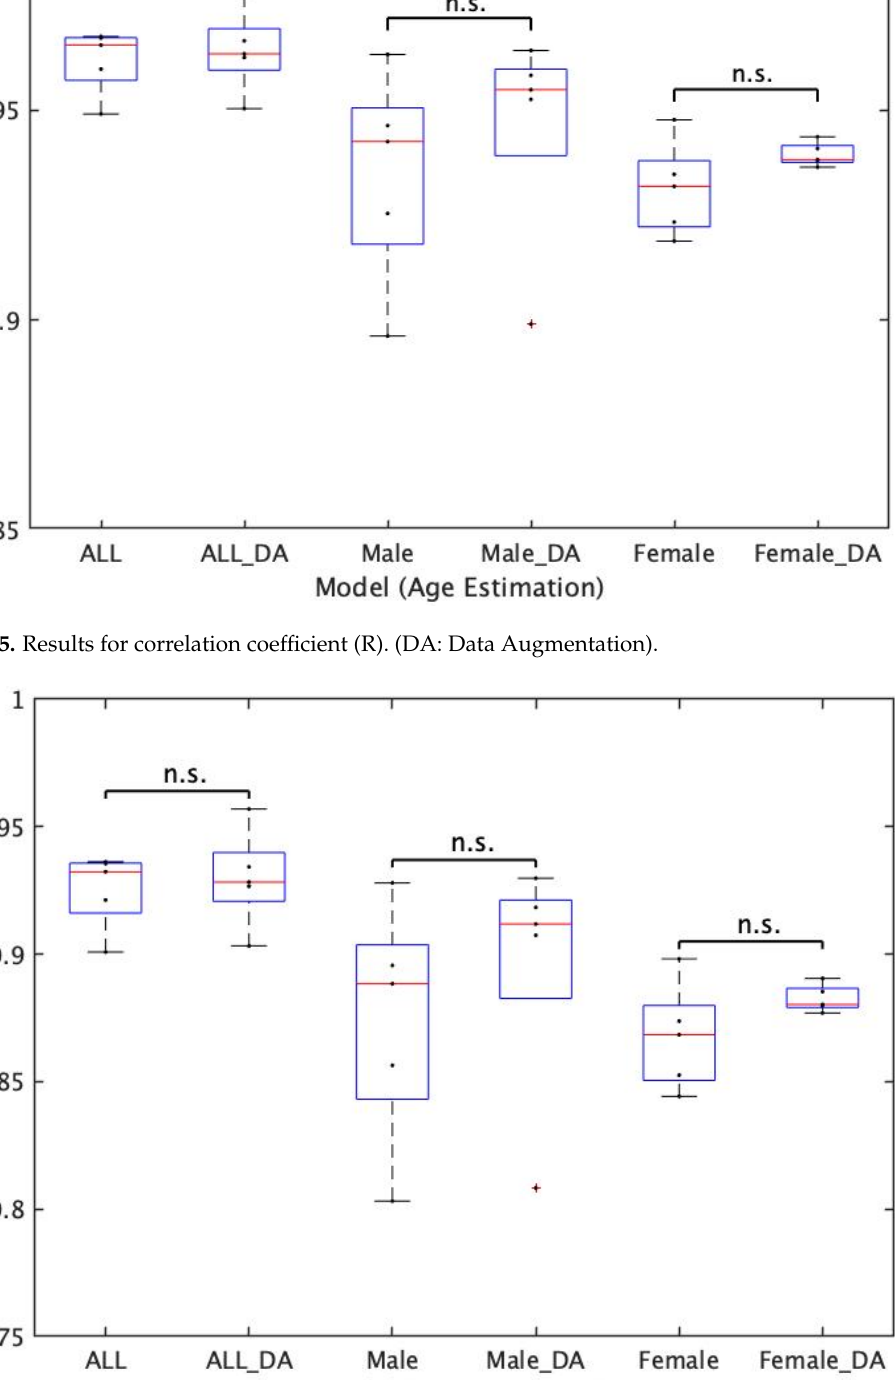
Figure 7. Results for mean absolute error (MAE). (DA: Data Augmentation).